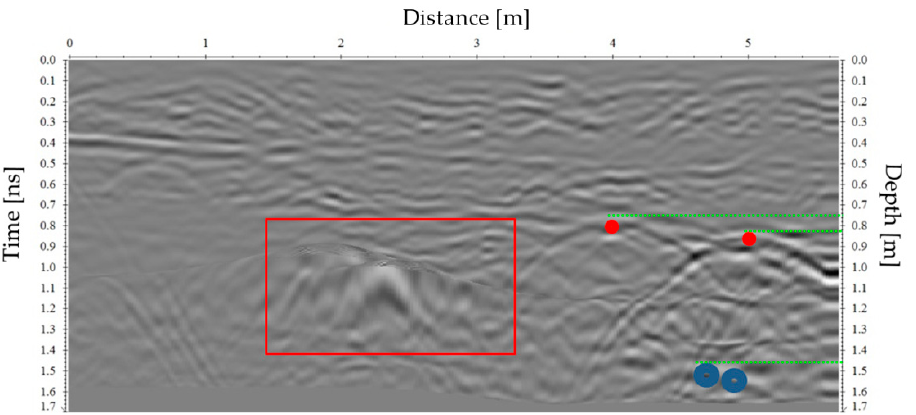
Figure 16. Time-to-depth conversion of profile 5 using a 900 MHz antenna with the velocity field calculated on the basis of the hyperbole fitting method.